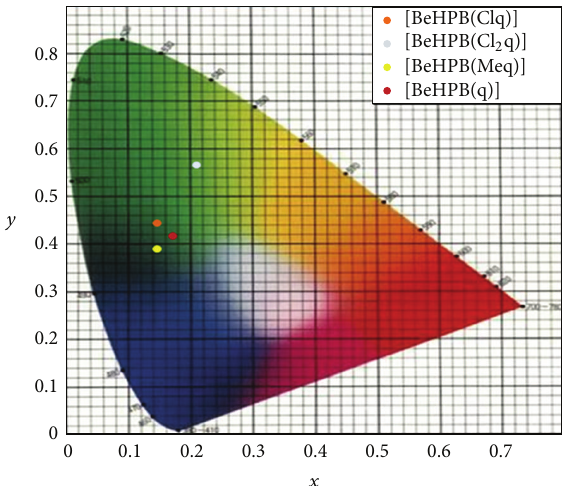
Figure 5: Photoluminescence spectra of beryllium(II) complexes in solid state.